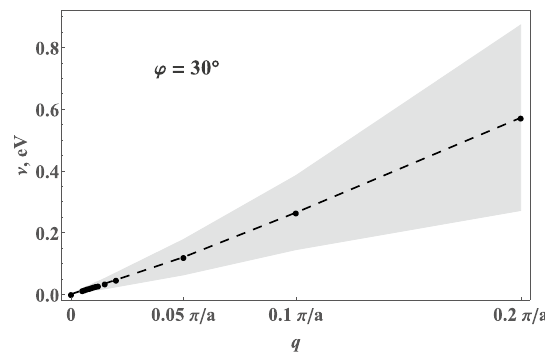
Fig. 4 The frequency dependences of the real (solid curve) and imaginary (dashed curve) parts of the dielectric permittivity ( a ) and the spectral function of the electron–electron interaction ( b ). Thick lines represent the numerical calculation in the framework of our model band dispersion, while the functions resulting from the ana- lytical calculation of polarization operator as superposition of con- tributions for spherical and hyperboloid parts, described in Sect. 2, are shown with thin lines